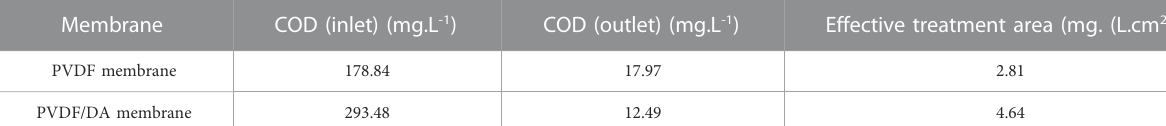
TABLE 4 Comparison of COD removal experiments before and after modi fi cation.